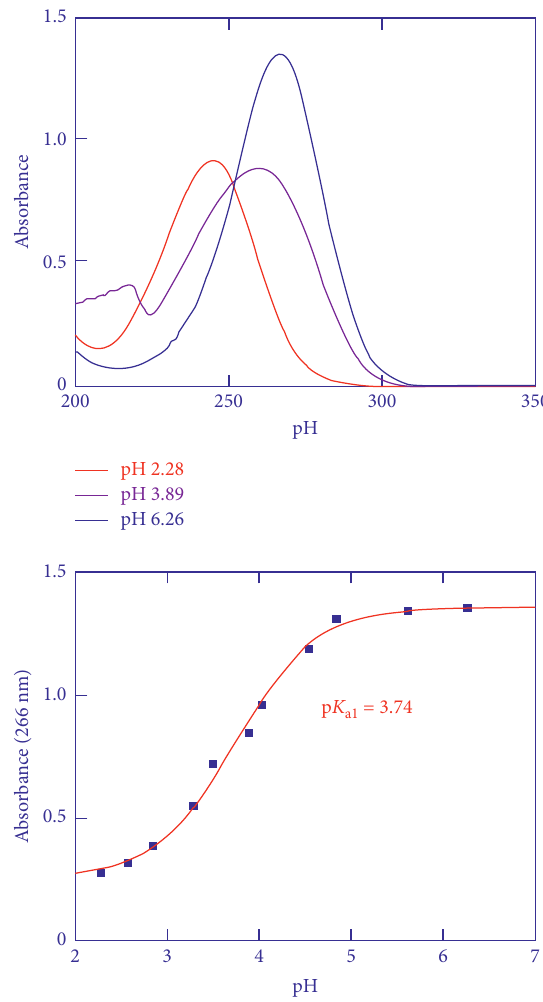
Figure 6: (a) Electronic spectra recorded for 0.10mM IAA in three different buffer solutions of 1.0M ionic strength at 25.0 ° C. (b) Absorption values at 266nm of 0.10mM IAA solutions as a function of pH at 25.0 ° C (data points). The solid line was obtained from the best fit of equation (3) to experimental data by use of a nonlinear least-squares